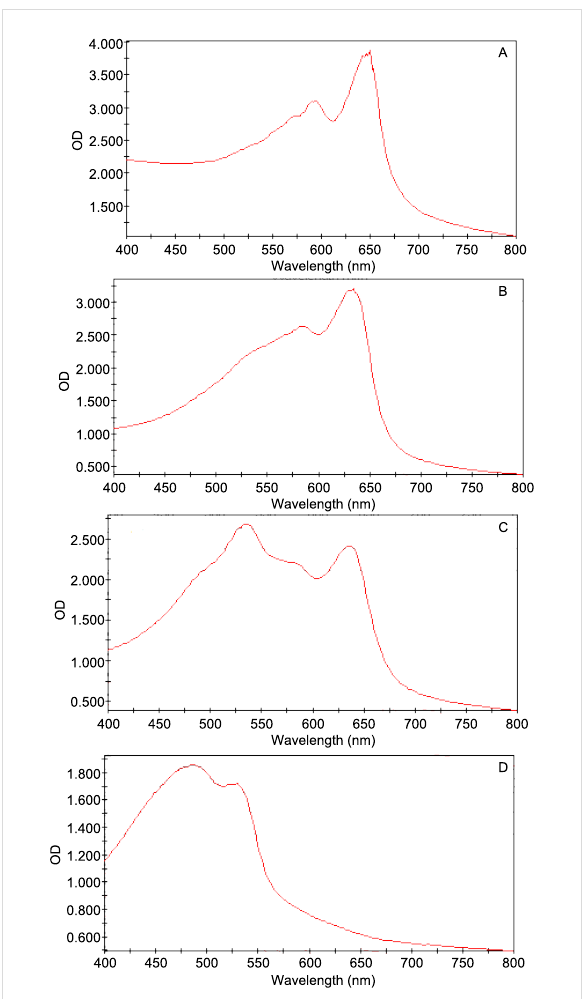
Figure 6: The UV–vis absorption spectra of the polymerized gel formed by compound 18A in ethanol (10 mg/mL): A, at room tempera- ture after 3 min UV irradiation ( λ max = 650 nm); B, at 50 °C ( λ max = 634 nm); C, at 60 °C incubation for 90 min ( λ max = 534 nm, other peaks are 582, 636 nm); D, after heating at above 60 °C till complete color change to red ( λ max = 486 nm together with 534